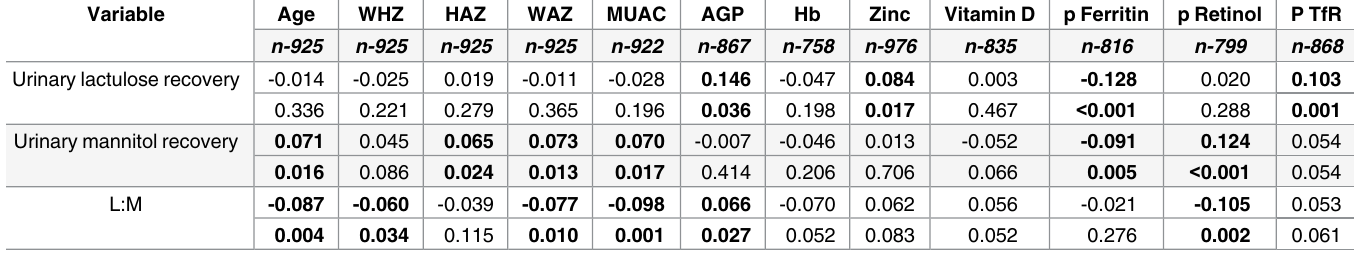
Table 2. Overall (among underweight- and well-nourished- children altogether) correlations (Spearman’s-rho) between lactulose/mannitol (L:M) test. Variable Age